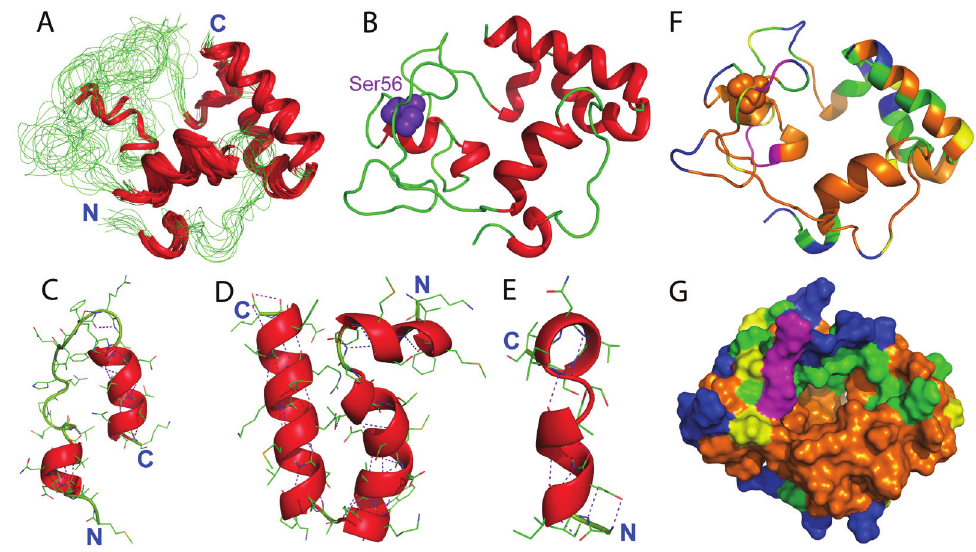
Figure 3. Three-dimensional structure of the P56S MSP in DPC micelles. A . Superimposition of the 10 selected NMR structures of the P56S MSP in DPC micelles. B . The lowest-energy structure. C . Two helices formed at the N-terminus. D . Three helices formed at the C-terminus; and E . Helices formed in the middle only found in two NMR structures. The purple dashed lines are used to indicate hydrogen bonds. F . Ribbon and G . surface representations of the P56S MSP in DPC micelle with the display of residues accessible to Mn2+ (green), to gadodiamide (blue). Yellow is used to color Pro residues and purple for residues with missing HSQC peaks.